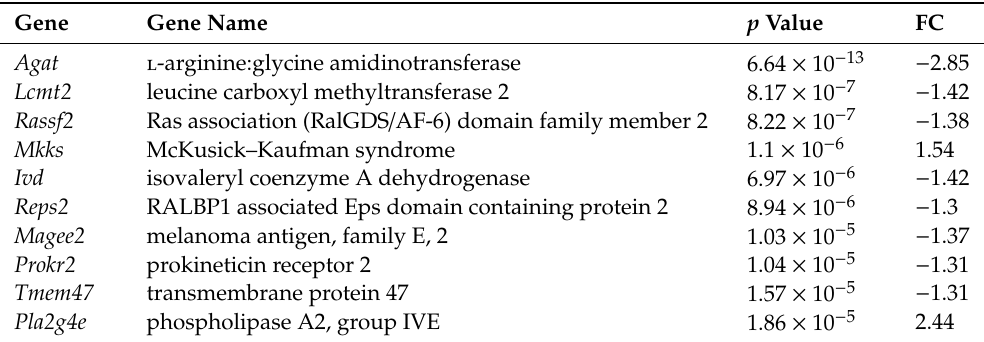
Table2. Di ff erentiallyexpressedgenesbetweenWTandAGAT − / − Crmiceinbraintissue. Falsediscovery rate ≤ 0.05. Abbreviations: FC, fold change.